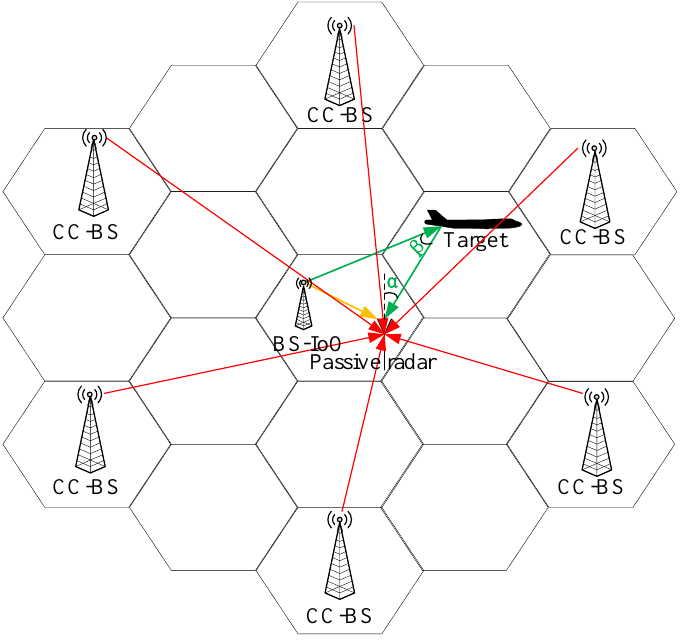
Figure 1. Schematic diagram of radar target detection structure for mobile communication passive radar.